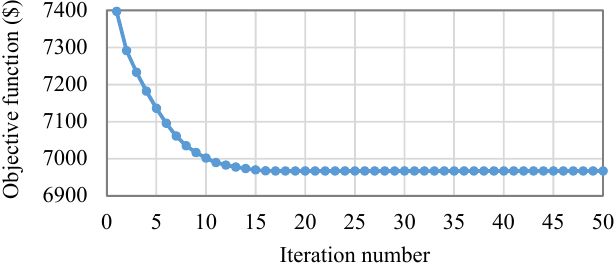
Figure 6. f 1 minimization through the iterative NRLP dispatch procedure assuming 5% controllable load.